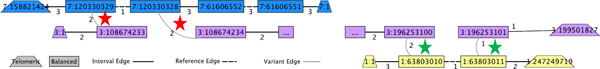
Reciprocal translocations in OV5. Examples of reciprocal Chr3/Chr7 (left) and Chr1/Chr3 (right) translocations in OV5. The Chr3/Chr7 translocation has the same multiplicity on the variant edges (red stars) as well as on the corresponding pairs of incident interval edges making it trivial. The Chr1/Chr3 translocation has different multiplicities on the variant edges (green stars) and is therefore non-trivial. In the Chr1/Chr3 translocation there is a single copy of Chr1 that does not use any variant edges, suggesting that only one copy of Chr1 is involved in the translocation, and that duplication of one of the translocated chromosomes occurs subsequent to the translocation.